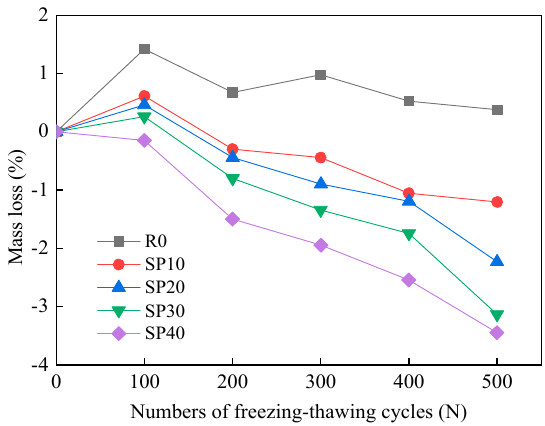
Figure 12. E ff ect of slag powder content on mass loss of CGAC. Figure 12. Effect of slag powder content on mass loss of CGAC. Figure 12. Effect of slag powder content on mass loss of CGAC.